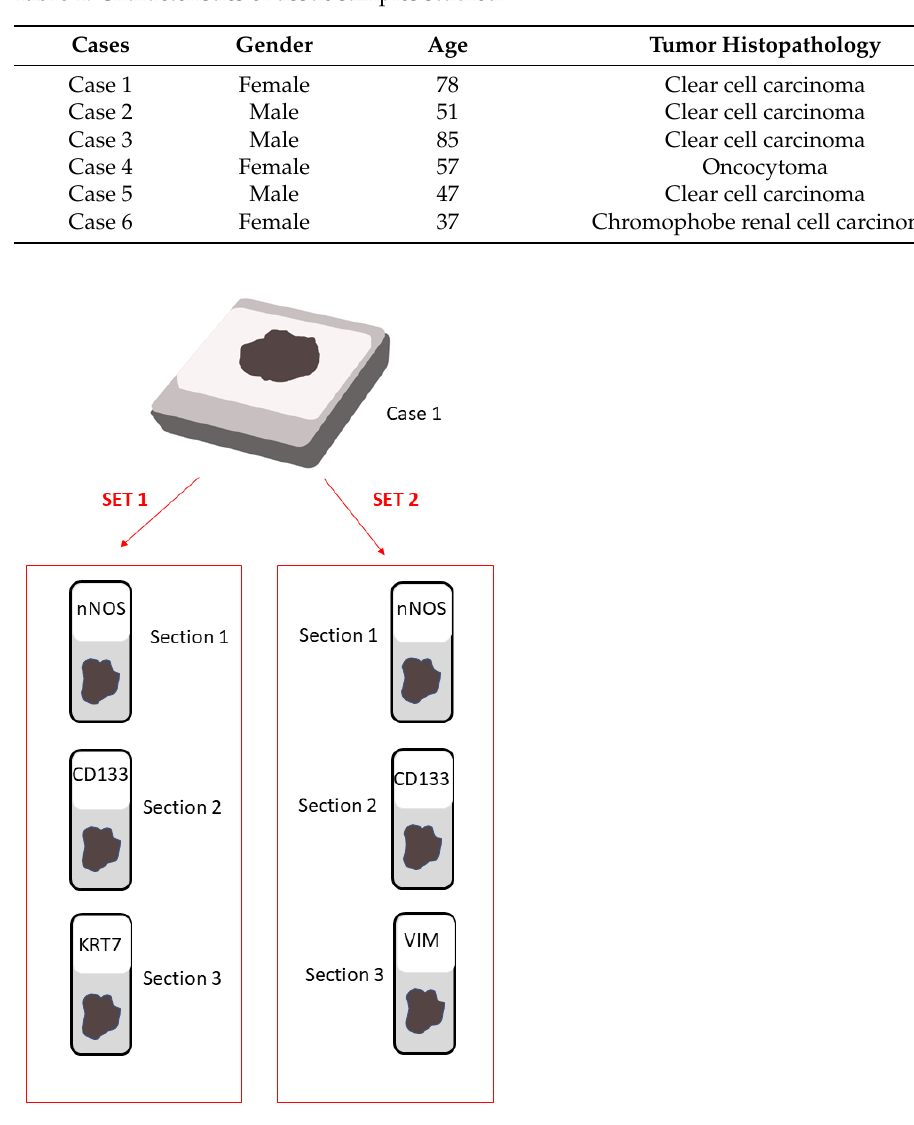
Figure 8. A schematic representation of the serial section setting. We prepared two sets of 3 serial sections (4 µ m each one) in order to be sure to obtain at least a part of the macula densa (MD) (since it is arranged in 5–6 layers, extending for about 40 µ m [14]). Moreover, in order to ensure the presence of MD in the section, the first sections of each set were stained for nNOS (a specific marker of MD) while the second sections of each set were stained for CD133. The third sections were stained for Cytokeratin 7 (KRT7, in set 1) and vimentin (VIM, in set 2). The figure has been created by Adobe Illustrator software (version 26.4.1; Adobe Inc., San Jose, CA,